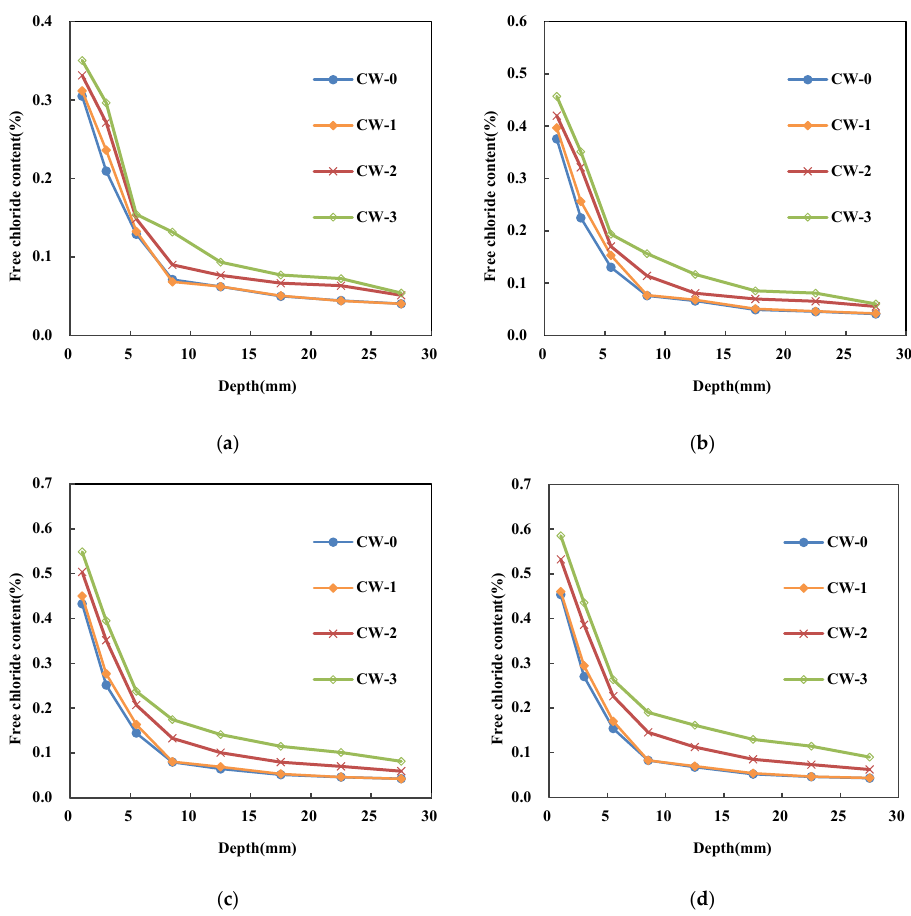
Figure 2. Variation of free chloride content with crack depth. ( a ) 30 days ( b ) 60 days ( c ) 90 days ( d ) 120 days.